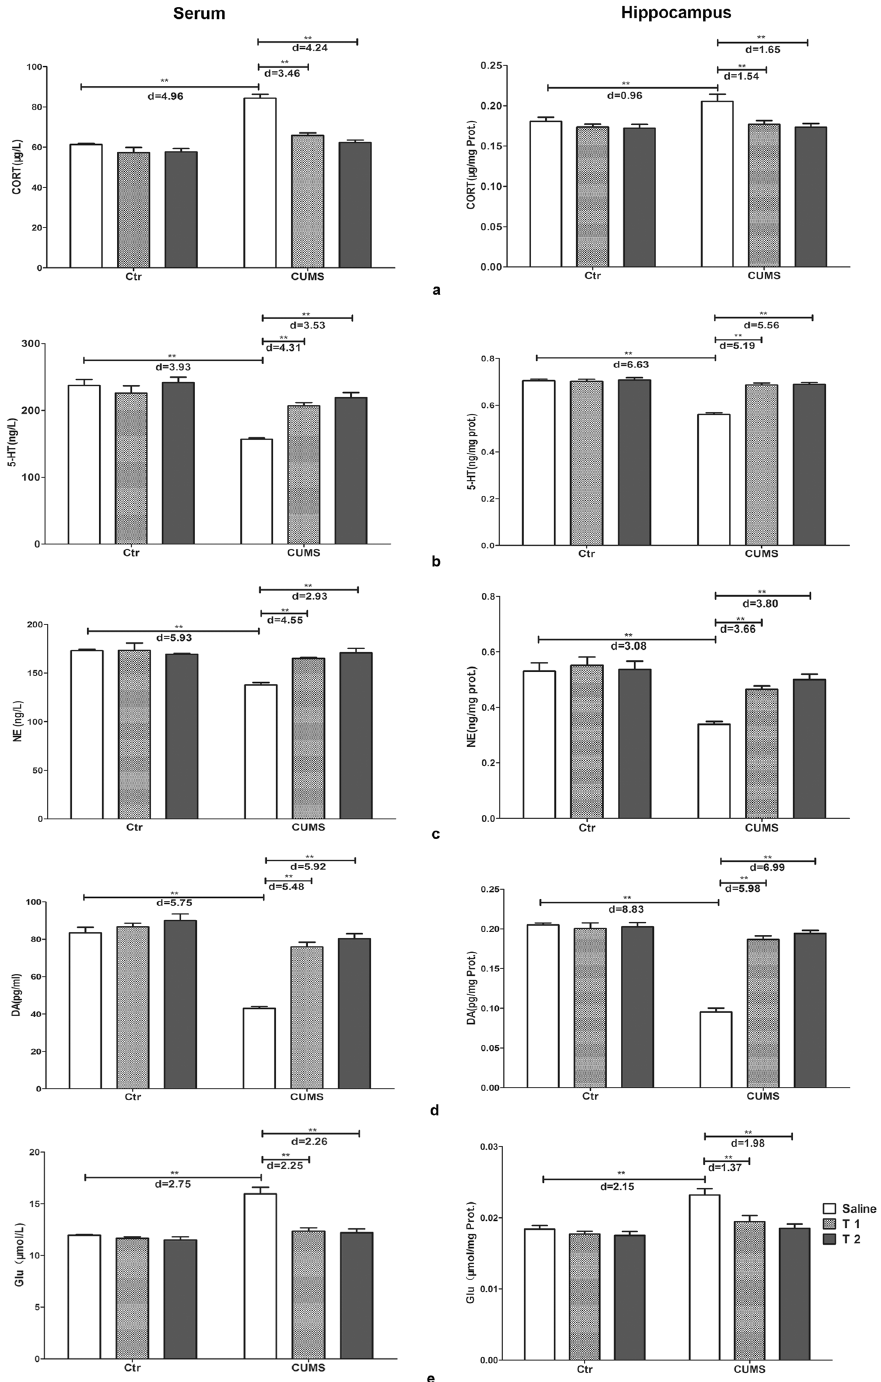
Figure 5. Effects of taurine on the concentrations of CORT and neurotransmitters. ( a ) Concentrations of CORT in the serum and hippocampus. ( b ) Concentrations of 5-HT in the serum and hippocampus. ( c ) Concentrations of DA in the serum and hippocampus. ( d ) Concentrations of NE in the serum and hippocampus. ( e ) Concentrations of Glu in the serum and hippocampus. Ctr, control group; CUMS, CUMS group; Saline, i.p. saline; T1, i.p. 200 mg/kg taurine; T2, i.p. 500 mg/kg taurine; All data are expressed as means ± SE and were analyzed by two-way ANOVA followed by Bonferroni’s multiple comparisons post hoc test (n = 10). * P < 0.003 vs. CUMS group; ** P < 0.00067 vs. CUMS group. d means Cohen’s d, d = 0.20 was considered as small effect size, d = 0.50 was considered as medium effect size, d = 0.80 was considered as large effect